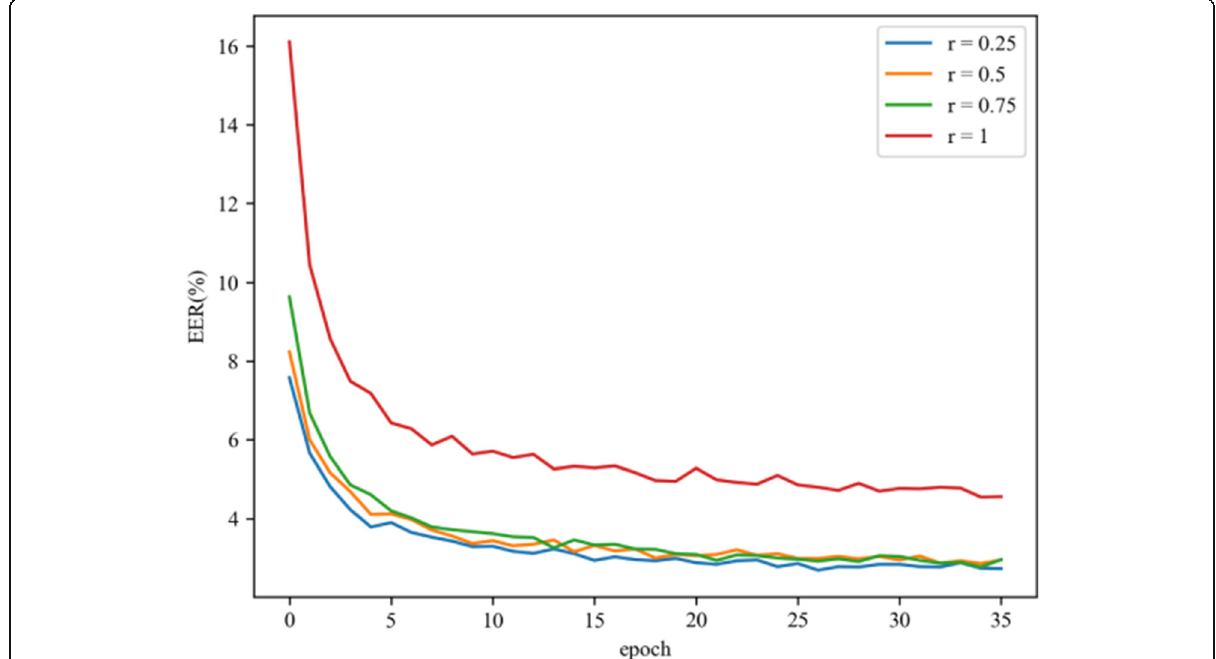
Fig. 10 EER curves during network